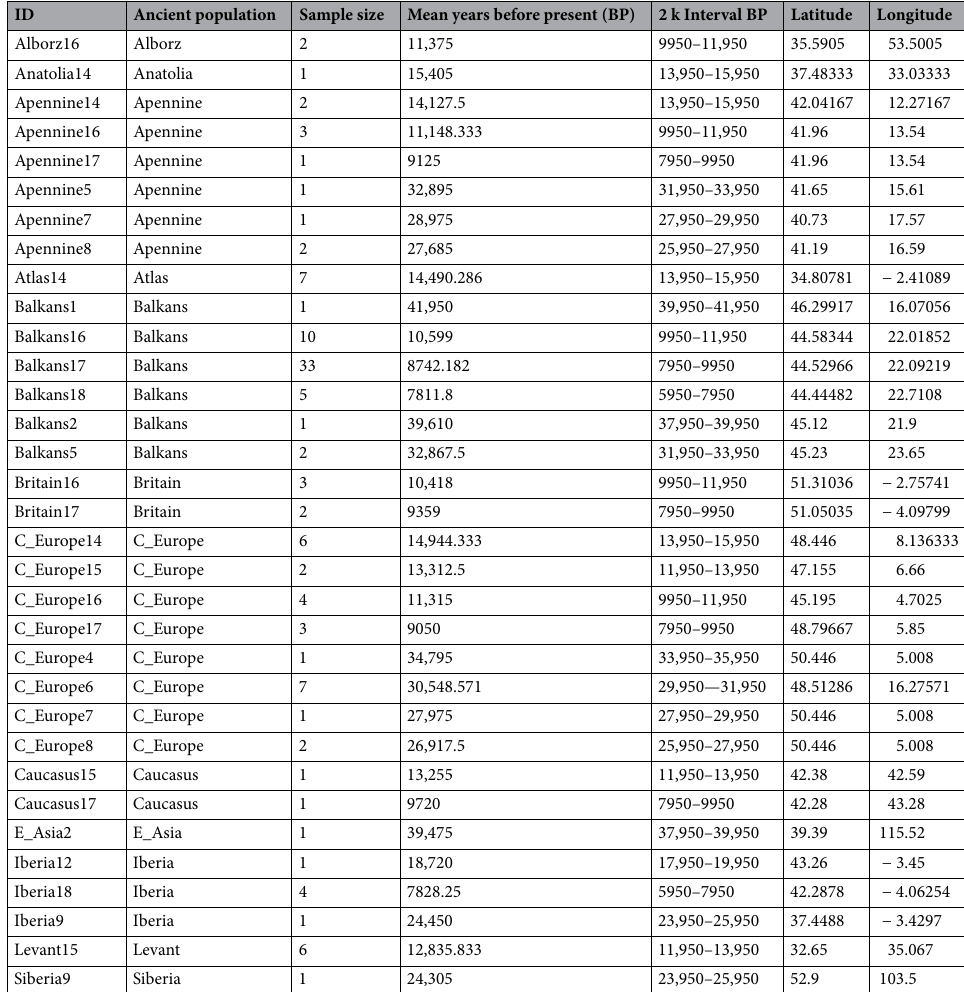
Table 2. Ancient study populations. The ancient genotypes are divided into 2000-year-long intervals, and then each of these intervals is grouped into geographic units (i.e. ancient populations). Age, latitude and longitude are averaged across each ancient population (see Supplementary Table S2 for